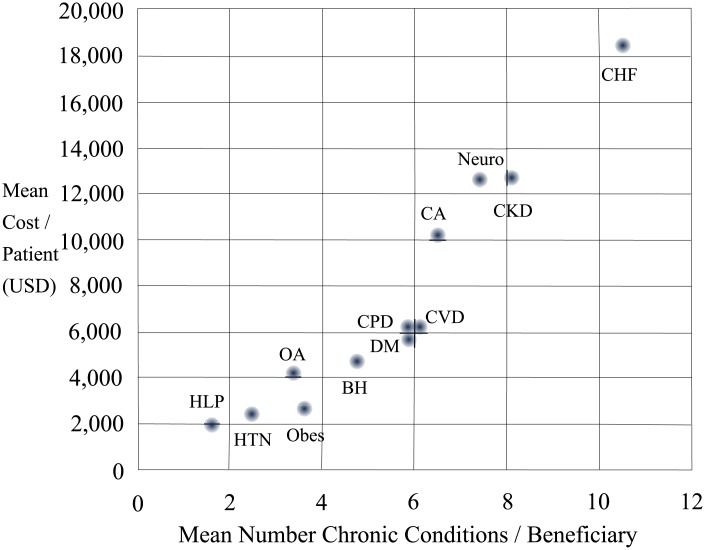
Relationship between mean number of CCs and mean paid claims across 12 groups of Medicare beneficiaries.The mean number of CCs per group is shown on the horizontal axis and the mean total of Medicare claims paid per group is depicted on the y-axis. Abbreviations for each group are the same as in Table 3.